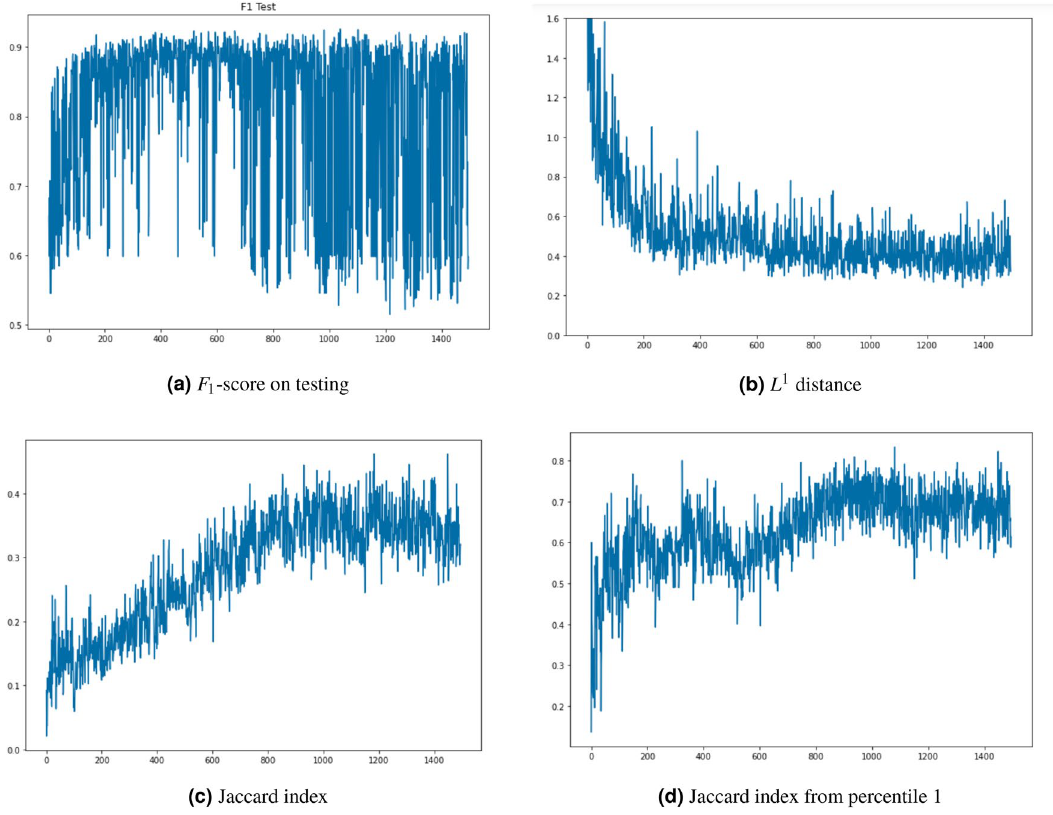
Figure 5. Evolution of F 1 -score on testing, L 1 distance and Jaccard index using GAN generator for label 1. The x -axis represents GAN training